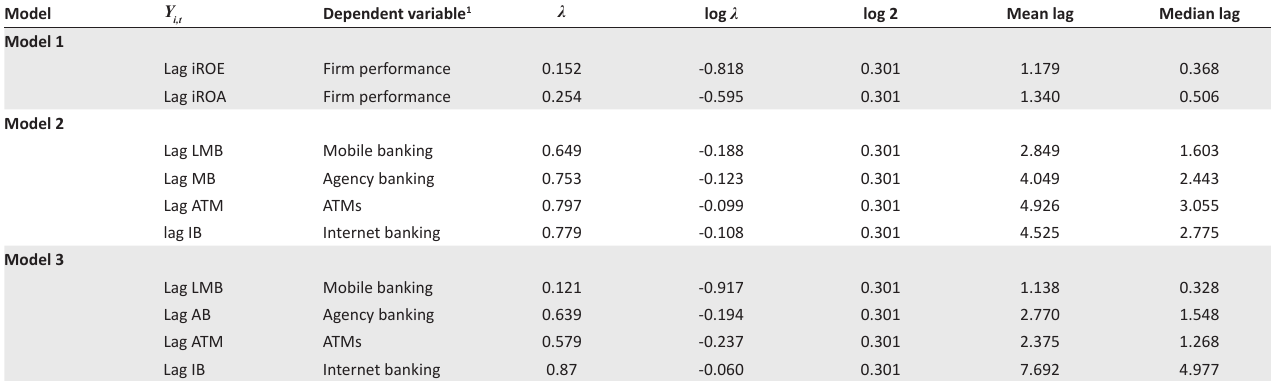
TABLE 2: Speeds of adjustment in models 1, 2 and 3.